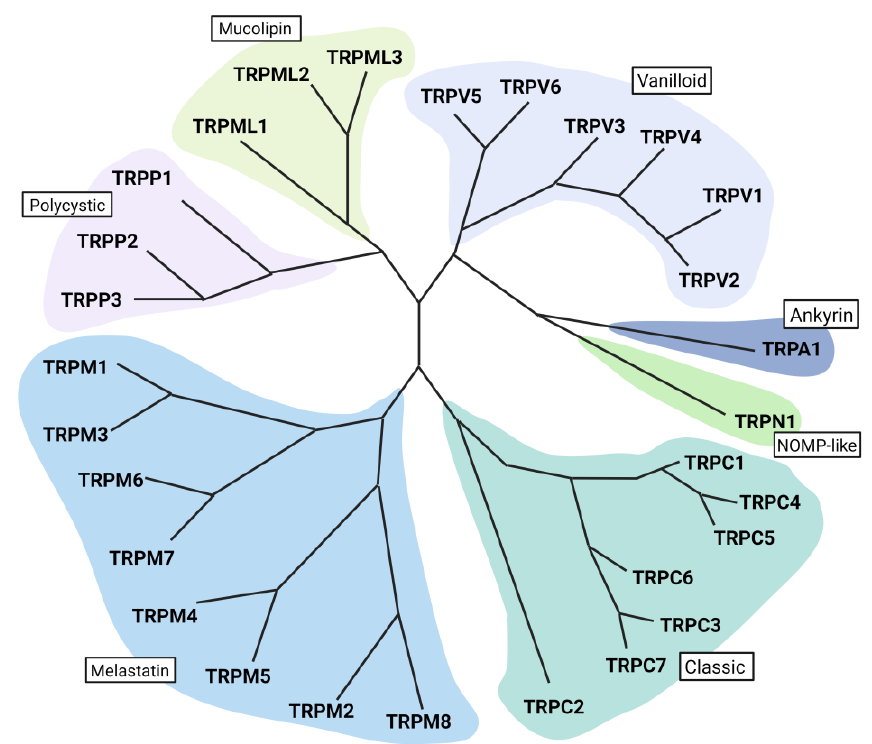
Figure 1. The transient receptor potential family encodes integral membrane proteins that function as ion channels. TRP channels are divided into seven subfamilies based on their homology of amino acid sequences. Most TRPs are nonselective cation channels and can be activated in a variety of ways, ranging from ligand binding, voltage, and temperature changes to covalent modification of nucleophilic amino acids. Activated TRP channels cause the depolarization of the cell membrane and are involved in the transcellular transport of many cations (Ca 2+ , Mg 2+ ), and they also contribute to the functioning of endosomes and lysosomes.